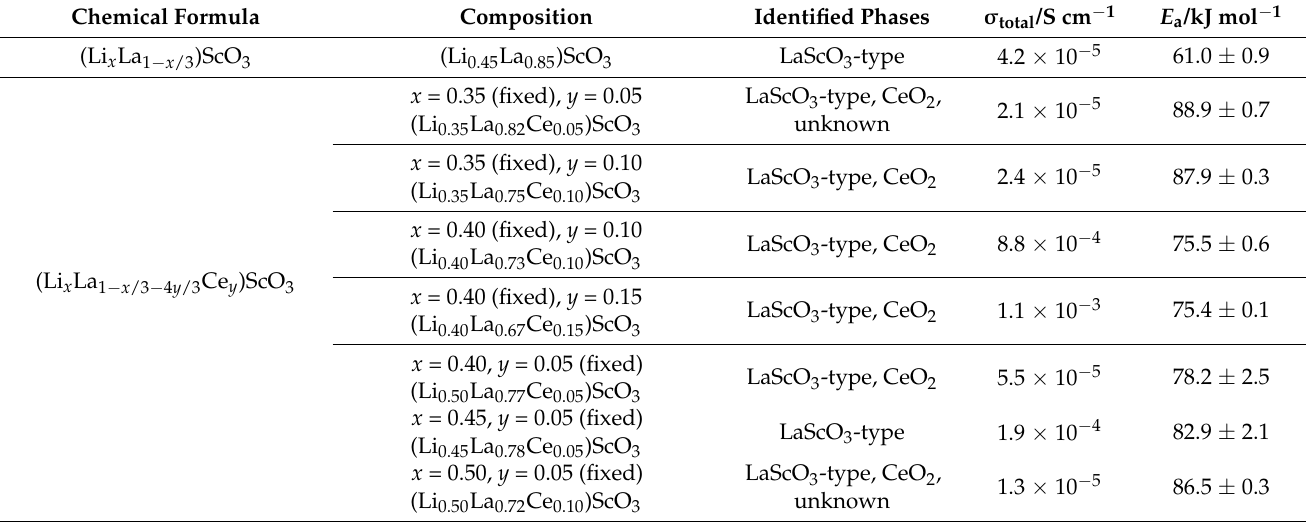
Table 2. Dependence of the ionic conductivities at 623 K and the activation energies on the Ce 4+ , Zr 4+ , and Nb 5+ co-doped (Li x La 1 − x /3 )ScO 3